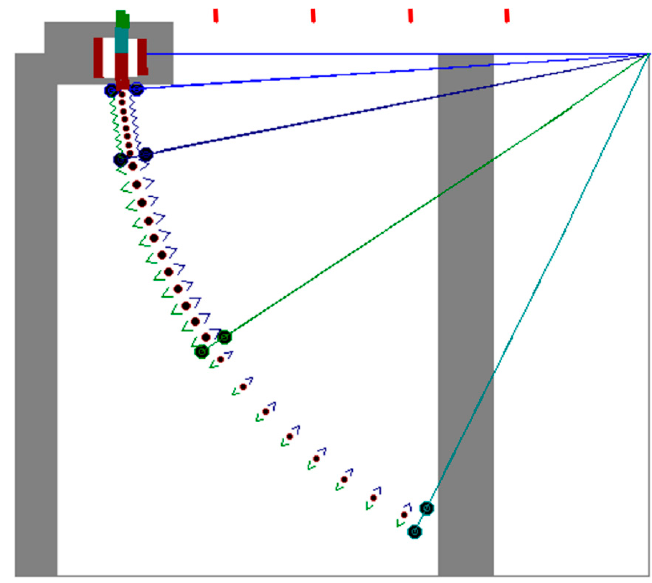
Figure 12. Layout of a symmetrical CCM (curved zone), case 2.